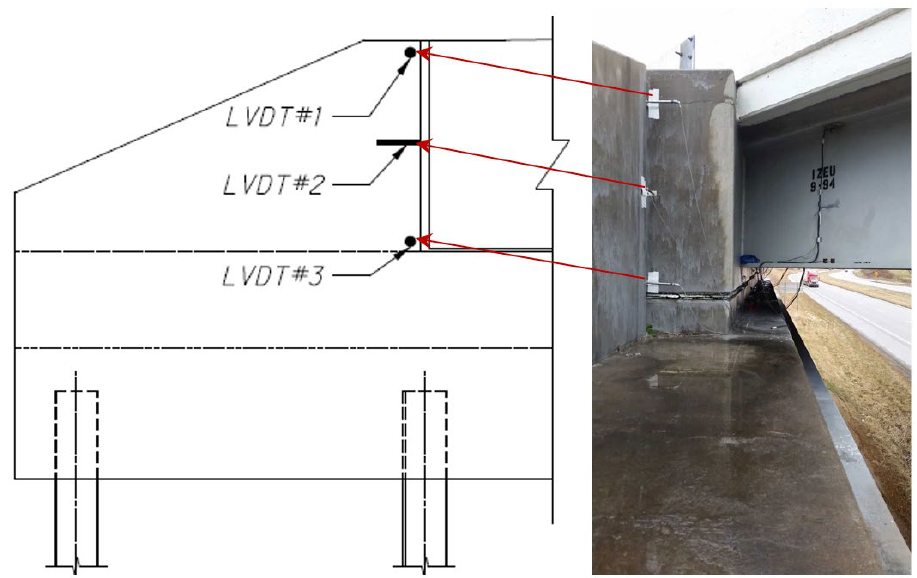
Figure 3. Instrumentation Layout and LVDTs Located at Wingwall.